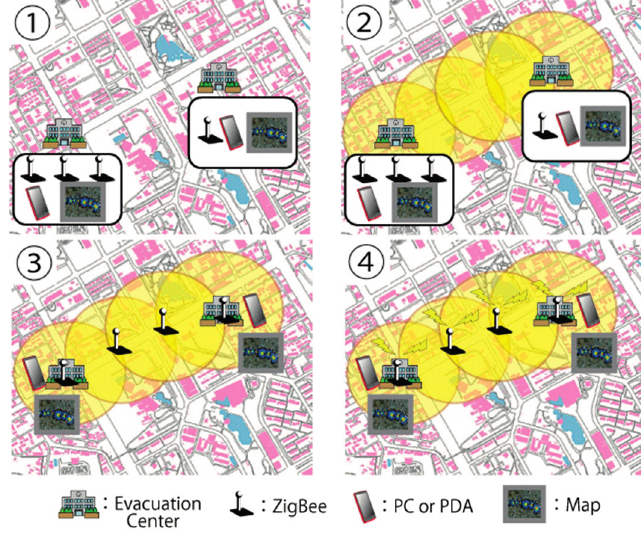
Figure 4. The process of establishing connections between centers: when the evacuation centers are established ① , the ZigBee network is planned ② , then the ZigBee nodes are located ③ , and the network can be used ④.